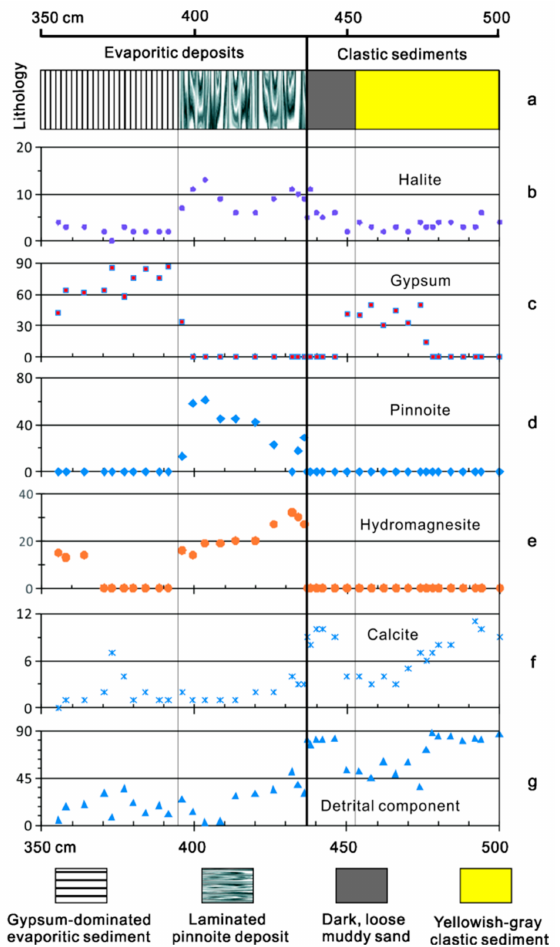
Figure 2. Lithology ( a ) and a mineral assemblage record ( b – g ) for the lower part (350–500 cm) of the D3 sediment section excavated from the middle of DaQaidam saline lake.